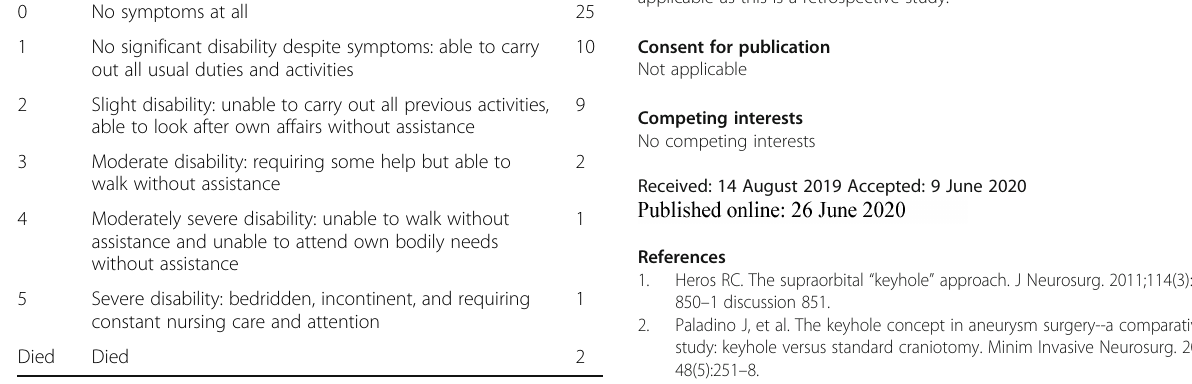
Table 3 Clinical outcome according to Modified Rankin scale Grade Description